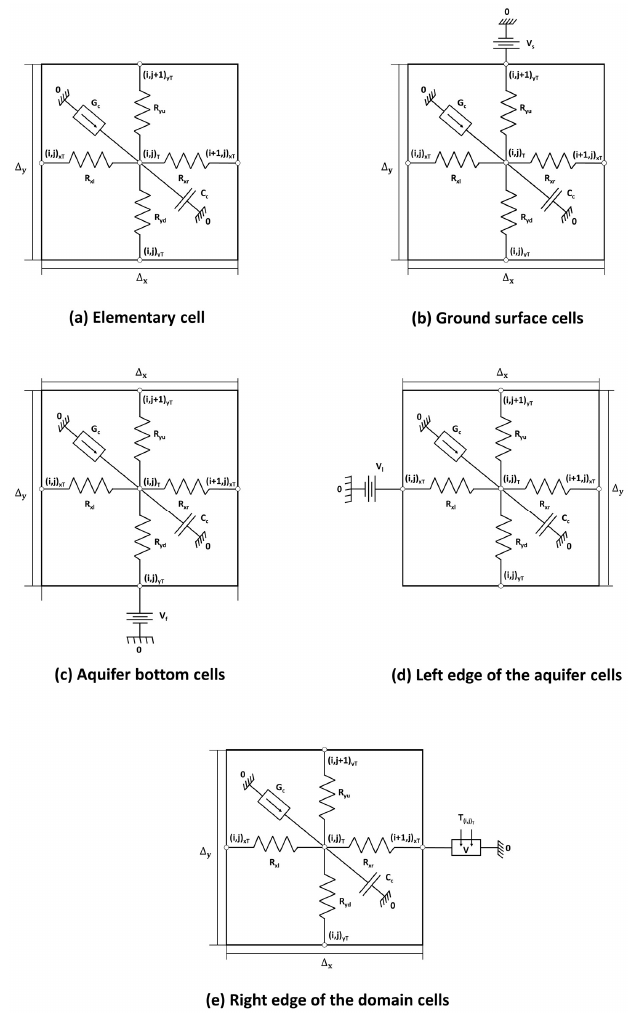
Figure 2. Network models in elementary cell ( a ), cells of the ground surface ( b ), bottom of the do- main ( c ), water inlet edge ( d ) and right edge of the domain ( e ). Spatial discretization of the governing equation for horizontal flow is: 1 ∆x(cid:3436)∆T ∆T 1 ∆y(cid:4678)∆T ∆T ∆T )dT k(cid:3428) ∆x(cid:3628) − ∆x(cid:3628) (cid:3440)(cid:3432) + k(cid:3429) ∆y(cid:3628) − ∆y(cid:3628) (cid:4679)(cid:3433) − (cid:3436)c (cid:2915),(cid:2933) ρ (cid:2915),(cid:2933) v (cid:2934),(cid:2925) ∆x(cid:3440) − (c (cid:2915) ρ (cid:2915) = 0 (7) dt (cid:2934) (cid:3126) (cid:2934) (cid:3127) (cid:2935) (cid:3126) (cid:2935) (cid:3127)